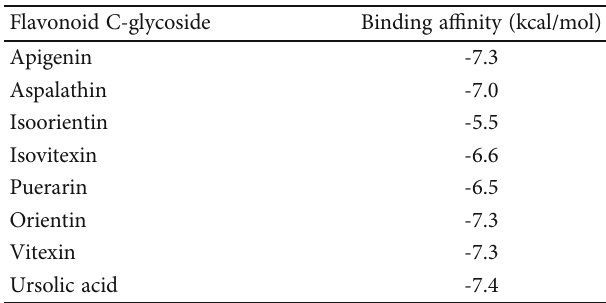
Table 1: Docking scores of complexations between fl avonoid C- glycoside compounds and